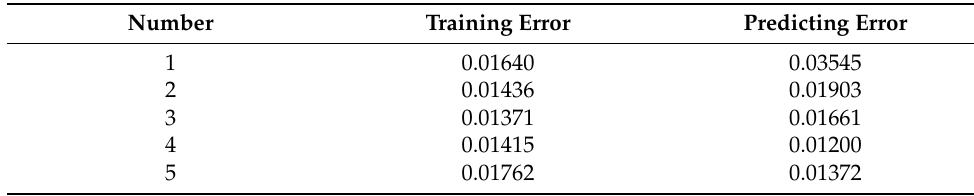
Table 2. Result of five-folded cross